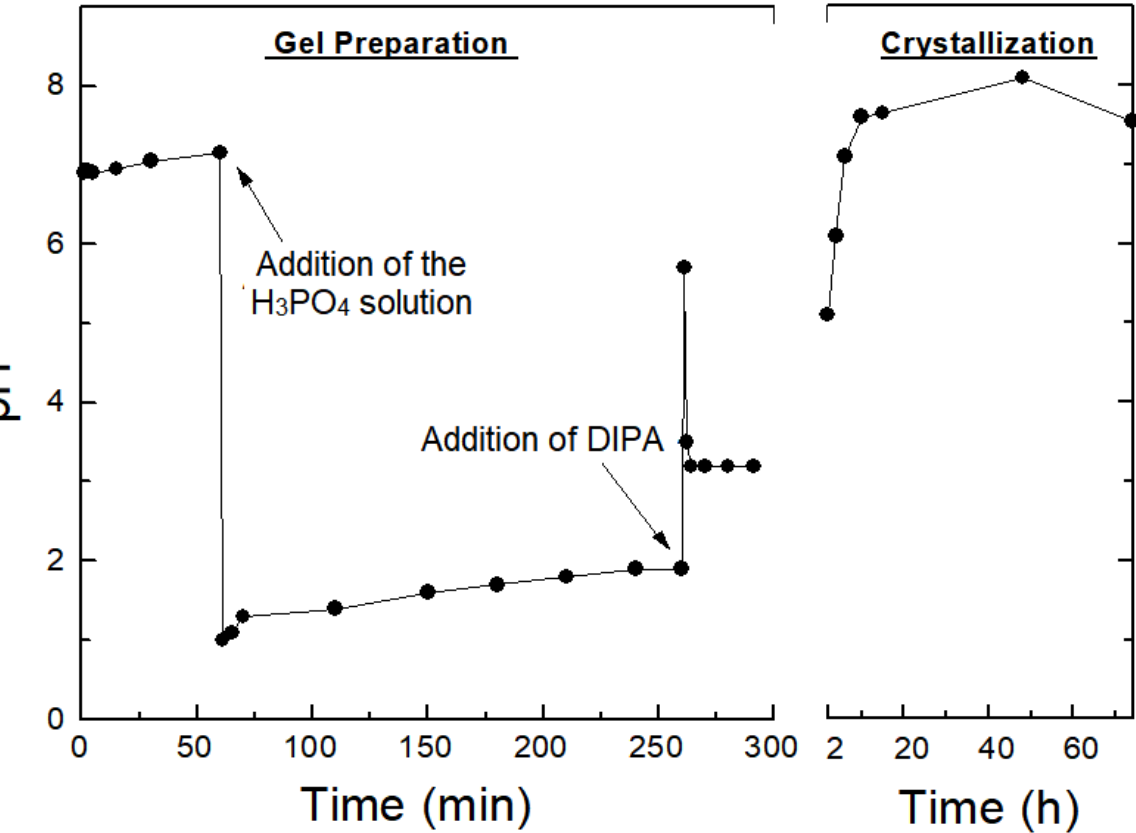
Figure 2. Curves of pH during the gel preparation and after remotion of each sample during the crystallization process.